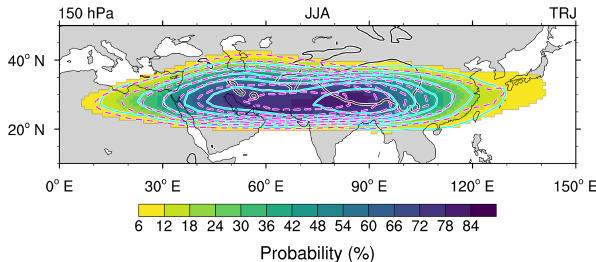
Figure 2. Probabilities (%) of starting locations for trajectories that start within the AMA at 150hPa during JJA in the TRJ calcula- tions. Trajectories were started daily at each 1 ◦ × 1 ◦ point within the region 10–50 ◦ N × 0–150 ◦ E and are said to be located within the AMA if the geopotential height anomaly from ERA-Interim (at 1.5 ◦ grid spacing) was higher than 280m (see text for further de- tails). Again, black contours show the 2km outline of ERA-Interim orography. Dashed magenta (solid cyan) contours (starting at 12% in steps of 12%) show the starting probabilities for the west (east) composites (see Sect. 2.3 for